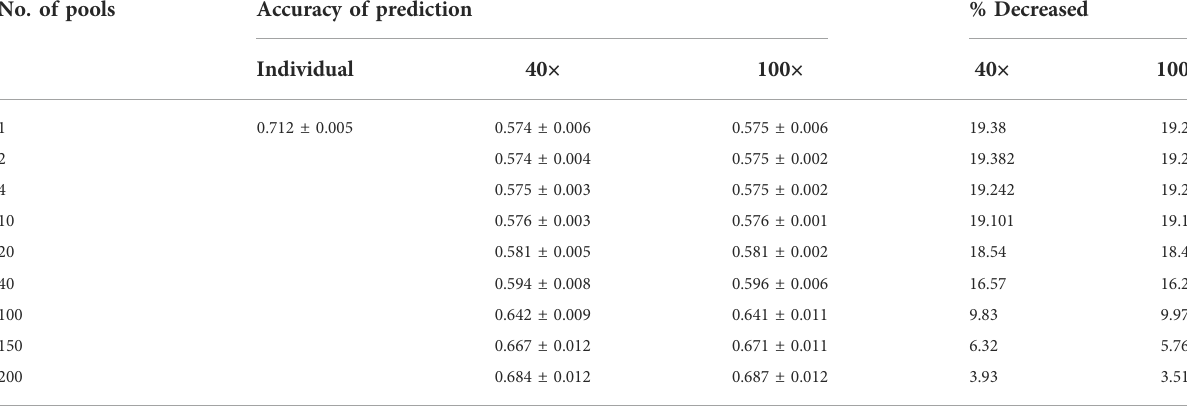
TABLE 2 Accuracy of selection of dataset-2 – in-silico DNA pooling. No. of pools Accuracy of